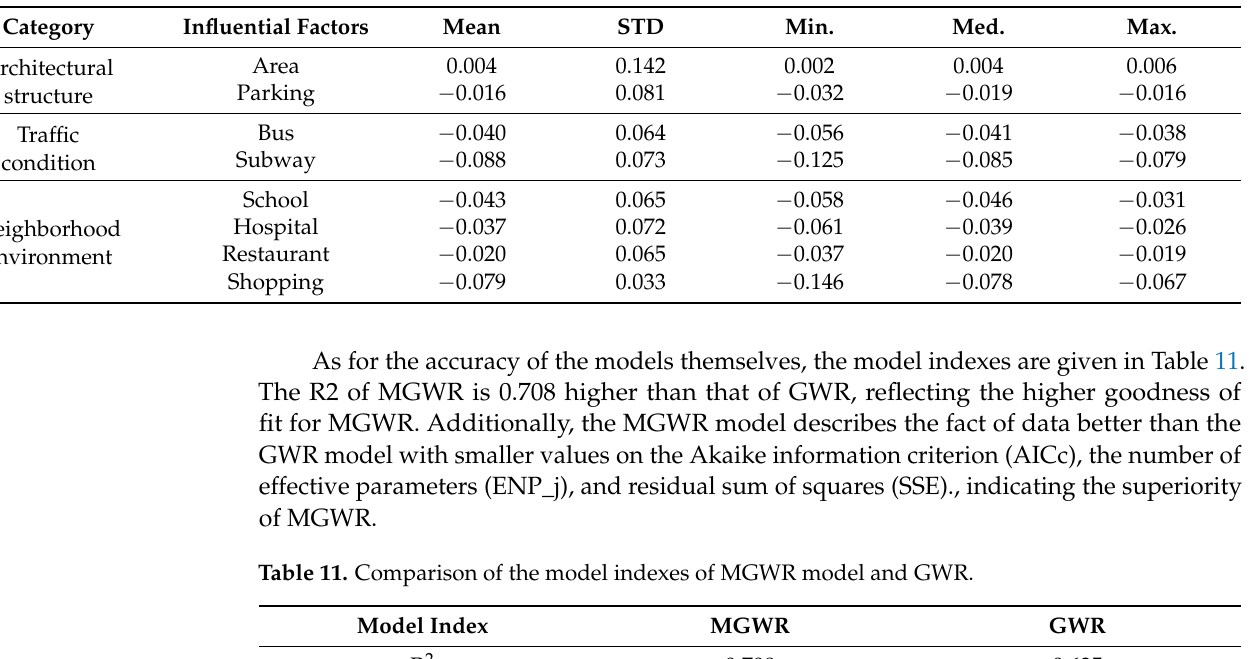
Table 10. The coefficient description of the GWR model.